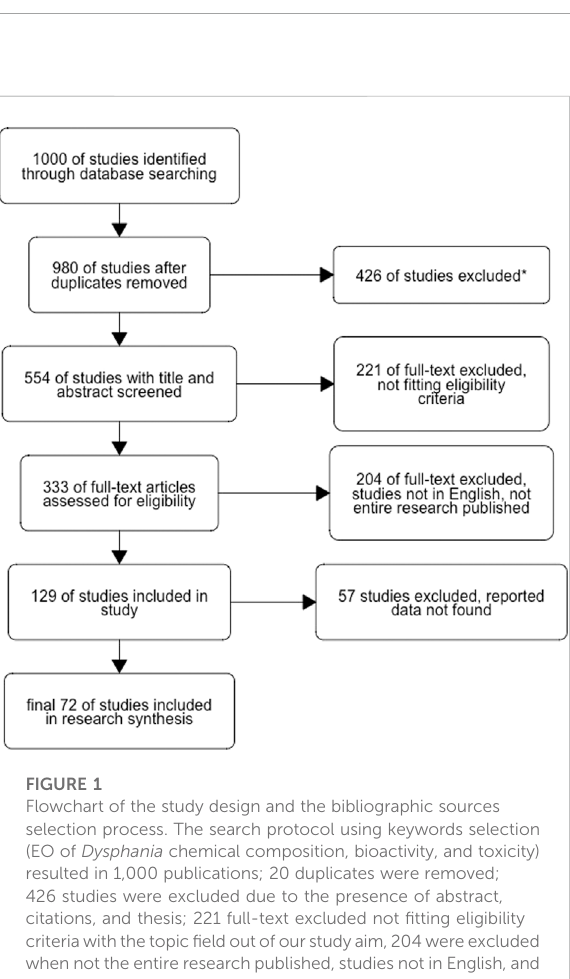
FIGURE 1 Flowchart of the study design and the bibliographic sources selection process. The search protocol using keywords selection (EO of Dysphania chemical composition, bioactivity, and toxicity) resulted in 1,000 publications; 20 duplicates were removed; 426 studies were excluded due to the presence of abstract, citations, and thesis; 221 full-text excluded not fi tting eligibility criteriawiththetopic fi eldoutofourstudyaim,204wereexcluded when not the entire research published, studies not in English, and 57studieswereexcludedbecausethedatareportedhavebeennot founded. The fi gure was done using R metagear